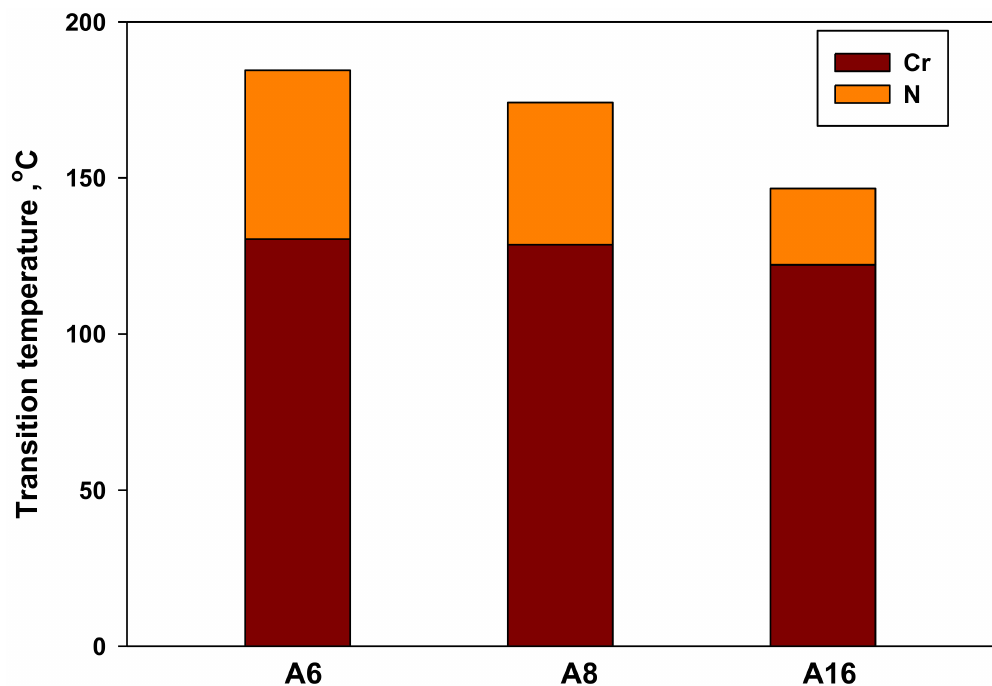
Figure 3. DSC transitions of synthesized groups An